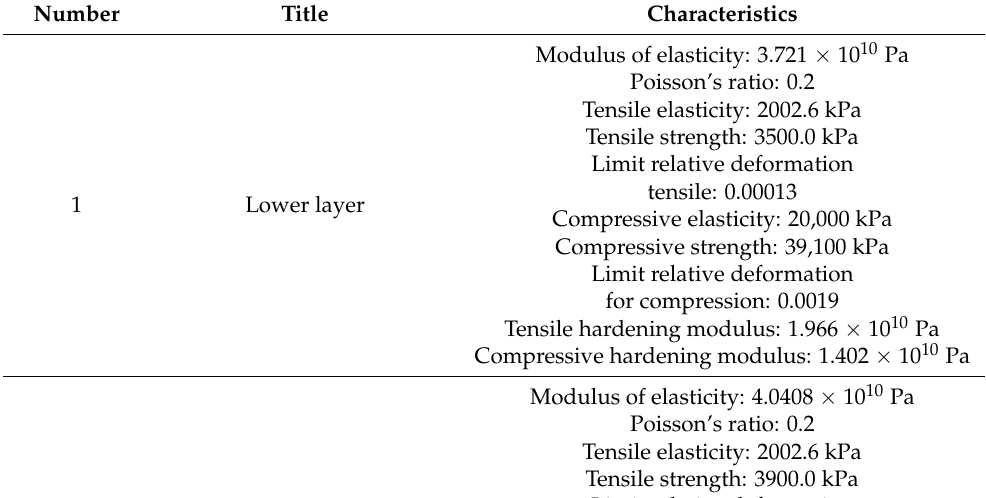
Table 2. Mechanical characteristics of the model